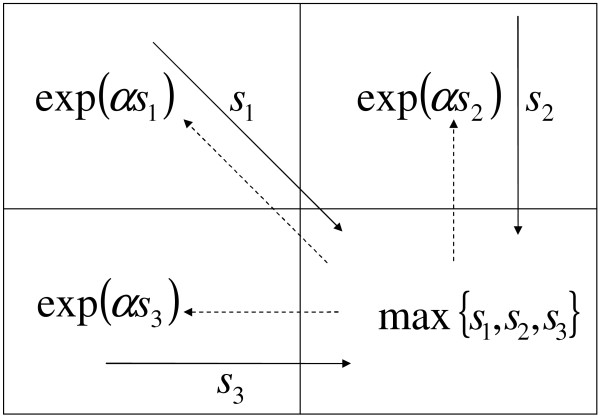
Generating the proposal alignment. This figure illustrates the stochastic sequence aligner. In the deterministic fill-in process, the three scores are s1, s2 and s3, hence the value in this cell is max{s1, s2, s3}. In the stochastic traceback phase, the three neighbor cells are choosen with probabilities proportional to exp(αsi), where α > 0 is a scaling parameter. The chosen traceback path corresponds to the proposed alignment in the usual way.